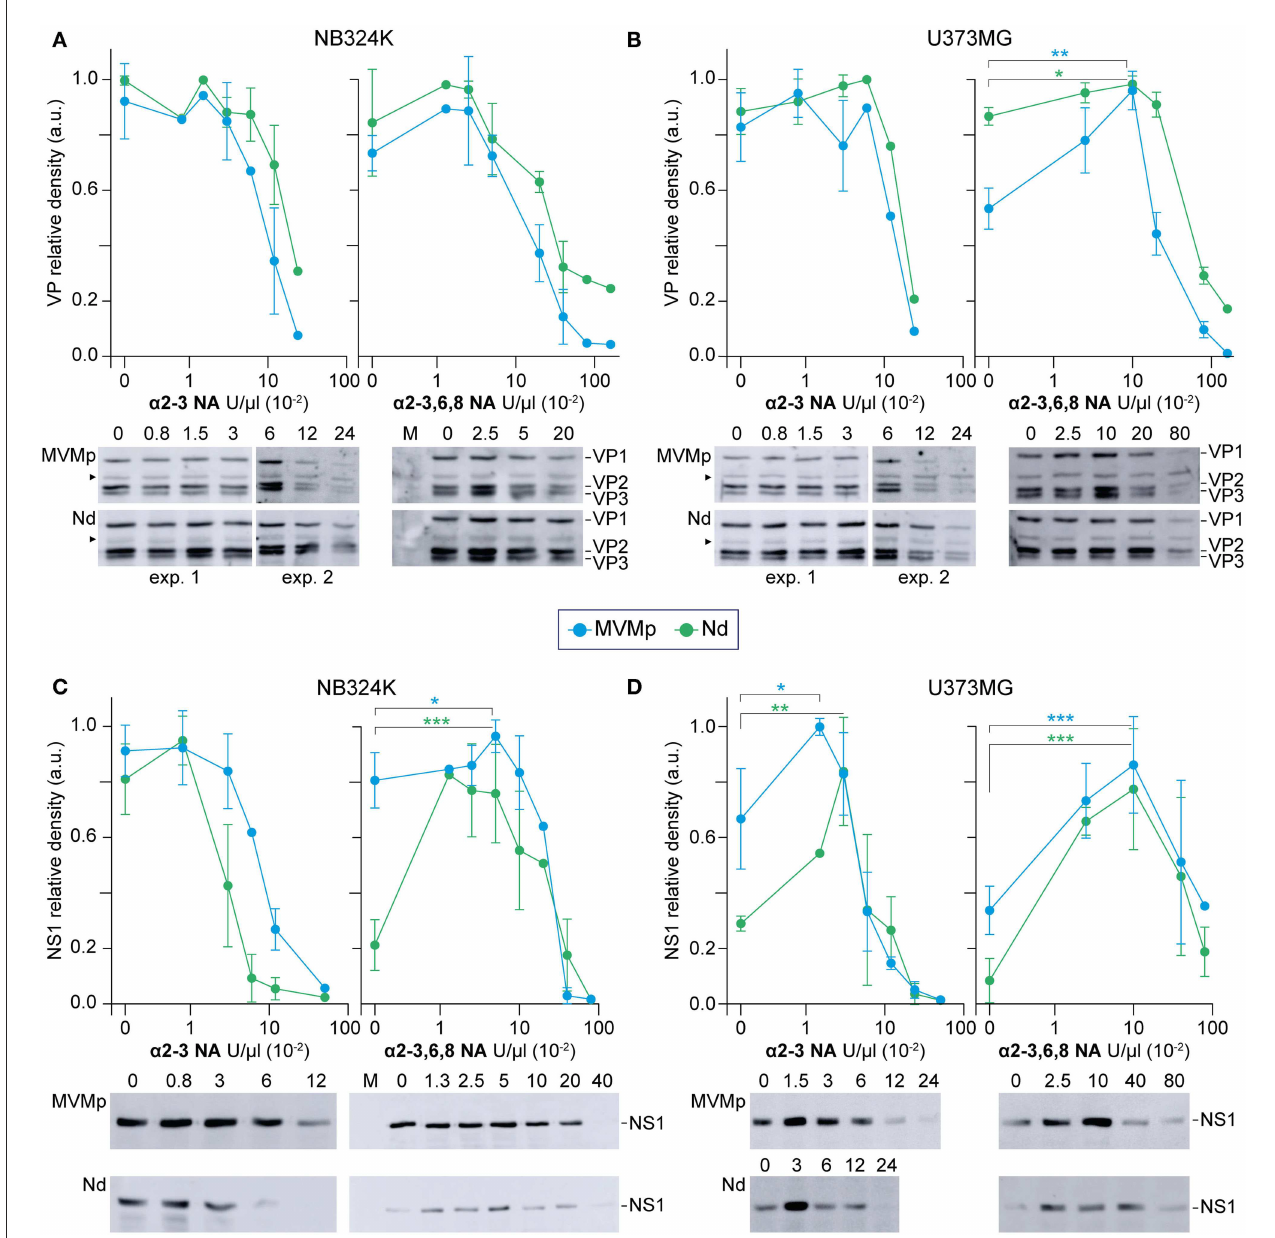
FIGURE5 Sialic acids distinctly contribute to MVMp and Nd virions binding and infection of human-transformed cells. The figure illustrates the effect of the α -2-3-NA and the α -2-3,6,8-NA sia cleaving neuraminidases on the binding and infection of MVMp and chimeric Nd virions in human-transformed NB324K fibroblasts and U373MG glioblastoma cells. Cell monolayers were inoculated with equivalent amounts of purified virions (8x10 12 viral particles per 10 5 cells) in the presence of the indicated concentrations of (left) α -2-3-NA and (right) α -2-3,6,8-NA sia cleaving neuraminidases. Samples were quantitatively analyzed in WB (see Materials and Methods) for: (A, B) Binding, developing for the structural proteins (VP1, VP2, VP3) after 1h adsorption; and (B, C) productive infection, developing for the viral NS1 protein expression at 20 hpi. Each experiment was seeded and performed entirely in parallel for the (A, C) and (B, D) determinations. Each point of the graphs with standard errors represents the average obtained from three to seven independent experiments. Protein density values were normalized in each experiment and means with standard deviations were obtained from the normalized